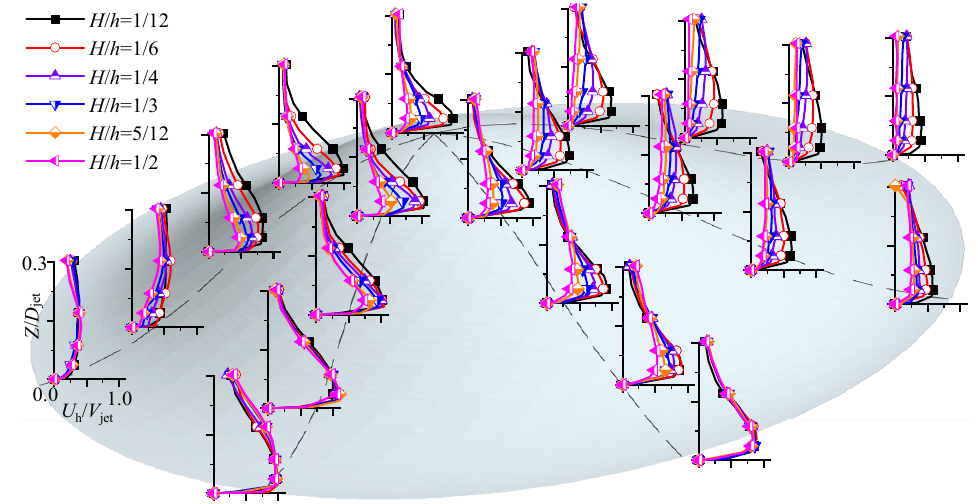
jet , r h = 1.0 D jet ).